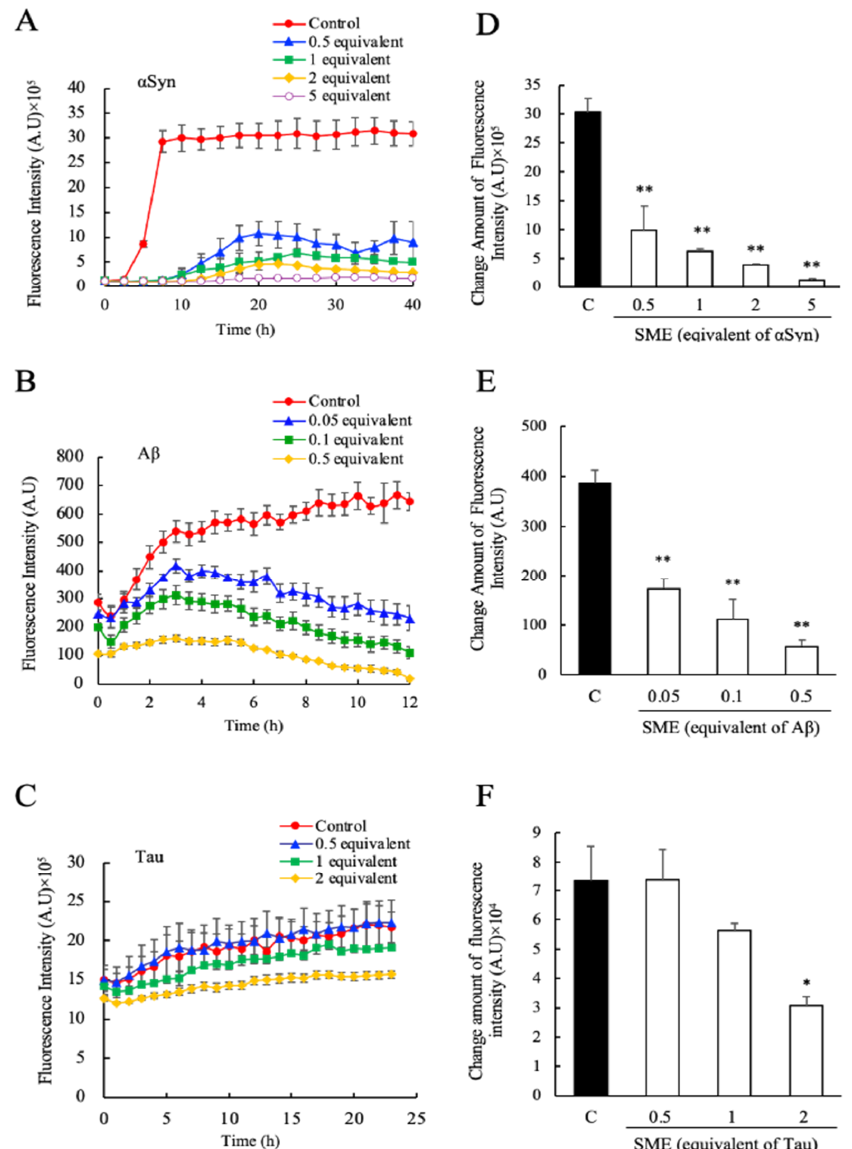
Figure 2. Inhibitory effects of spearmint extract (SME) against α-synuclein (αSyn), amyloid beta (Aβ), and Tau amyloid fibril formation. The degree of amyloid fibril formation was detected over time by measuring the specific fluorescence of fibril-bound thioflavin T (ThioT) in the presence and absence of SME; ( A ) αSyn (0.5–5 equivalents rosmarinic acid (RA)), ( B ) Aβ (0.05–0.5 equivalents RA), ( C ) Tau (0.5–2 equivalents RA). The net amount of fluorescence intensity change was estimated by the ratio between the maximum value and initial measurement value of its intensity; ( D ) αSyn, ( E ) Aβ, ( F ) Tau. Data are means ± SEM ( n = 3). C, control. * p < 0.05, ** p < 0.01 vs. the control group (Dunnett’s multiple comparison test).